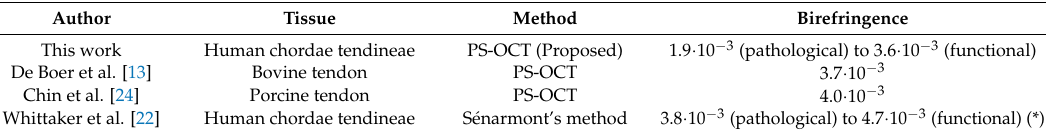
Table 2. Birefringence value for tendinous tissue obtained by different authors.